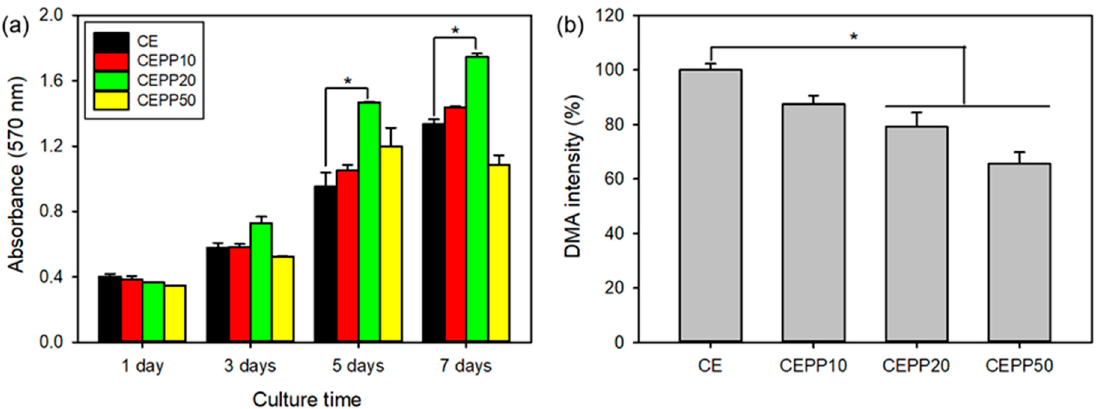
Figure 4. ( a ) Proliferation behavior of S16 cells cultured on the CEPP monoliths with laser irradiation ( n = 5) and ( b ) fluorescence intensity of DMA due to generation of singlet oxygen by the CEPP monoliths ( n = 6). The error bars indicate mean values ± SD. * p ˂ 0.05 for the comparison between two treatment groups.